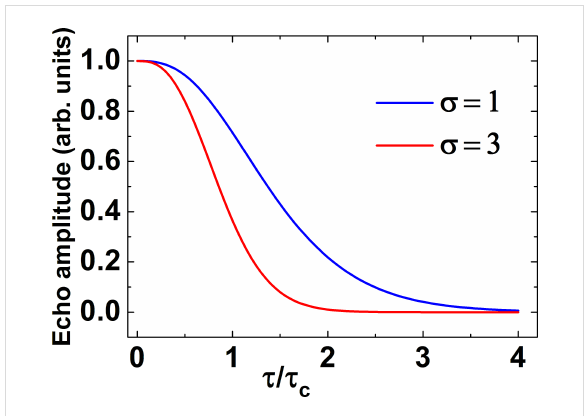
Figure 10: The calculated decay of the primary echo signal as a func- tion of the time delay τ between the two pulses. τ is measured in units of the correlation time τ c for the normal stochastic process of the spec- tral diffusion and the dispersion of the resonance frequency σ is given in units of 1/ τ c2 . The calculations were made for the two values of the dispersion σ = 1 (blue) and σ = 3 (red).